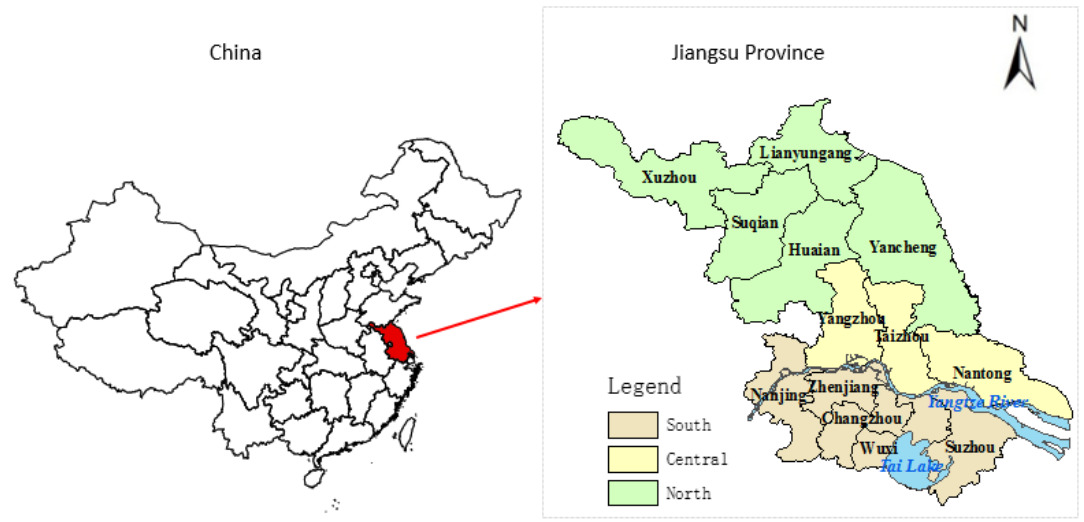
Figure 1. The study area, Jiangsu province, grouped into three regions: south, central and north. The south is the developed region, which includes Suzhou, Wuxi, Changzhou, Nanjing and Zhenjiang; the central is the developing region, which includes Yangzhou, Taizhou and Nantong; and the north